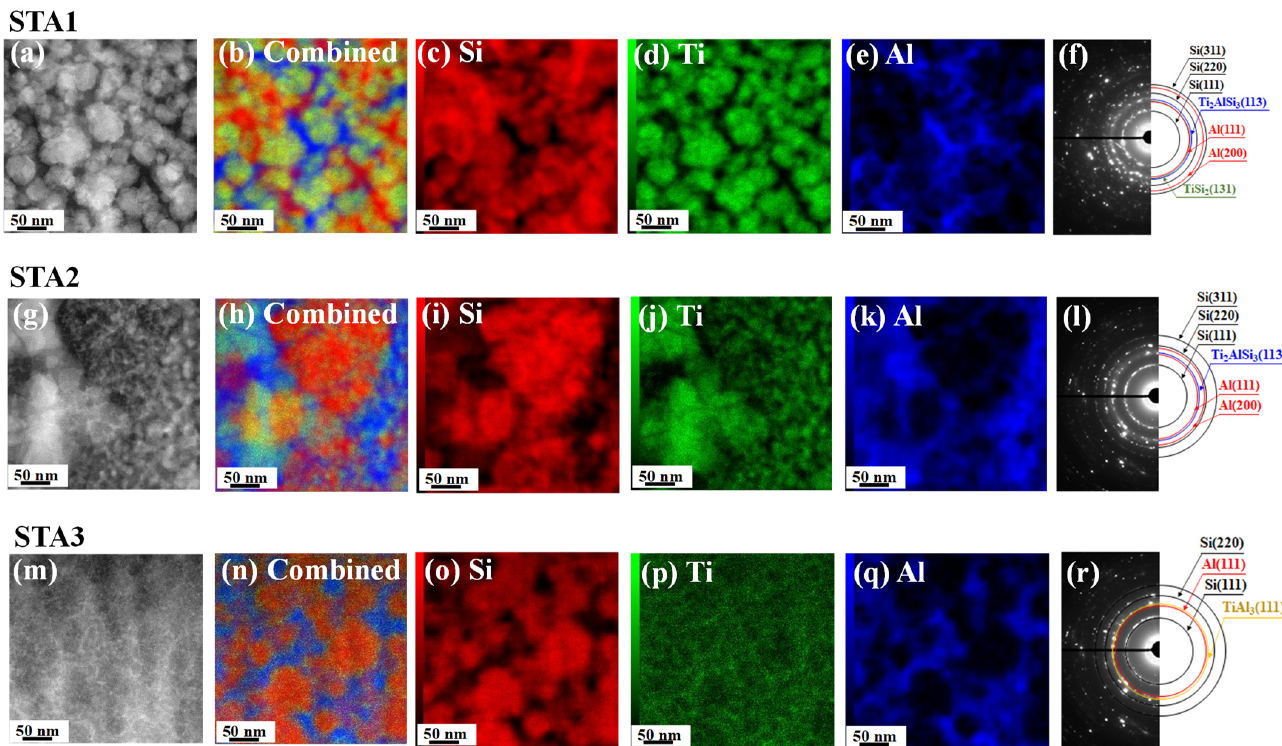
Figure 4. STEM images ( a , g , m ), EDX images ( b – e , h – k , n – q ), and SAED patterns ( f , l , r ) of STA1, STA2, and STA3.